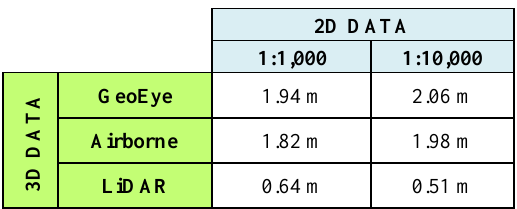
Table 2. Mean of the residual values for the different data.